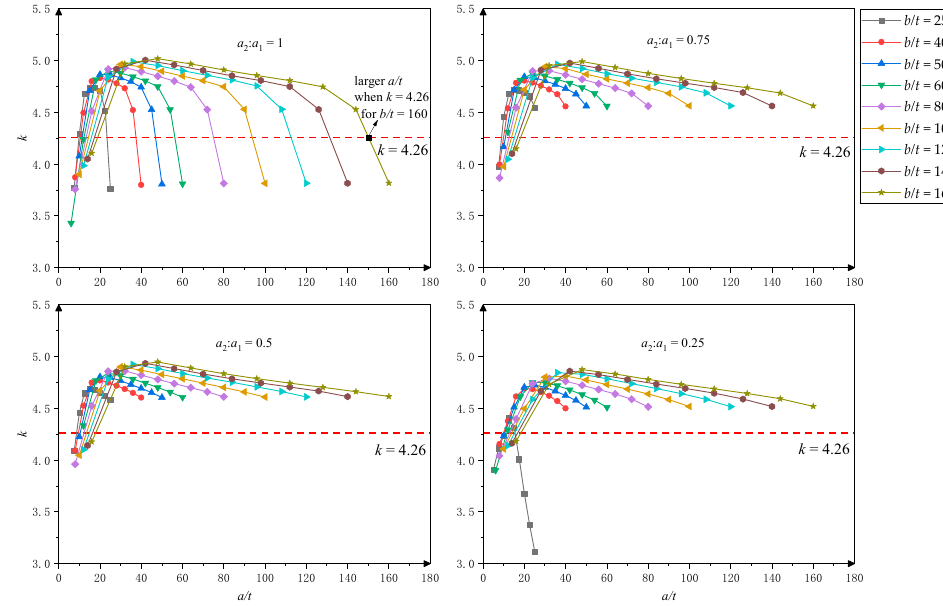
Figure 9. Values of k of the complex edge stiffeners for different a 2 / a 1 ratios.